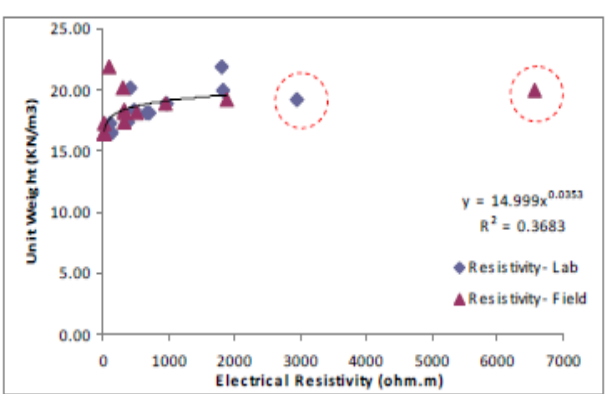
Fig. 3. Relationship between ER and MC